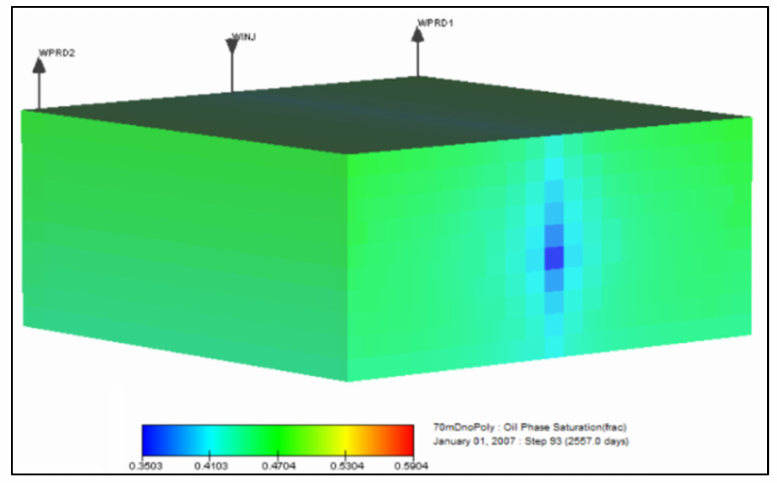
Figure 15. Reservoir residual oil saturation distribution at the end of the calculation period for displacement by